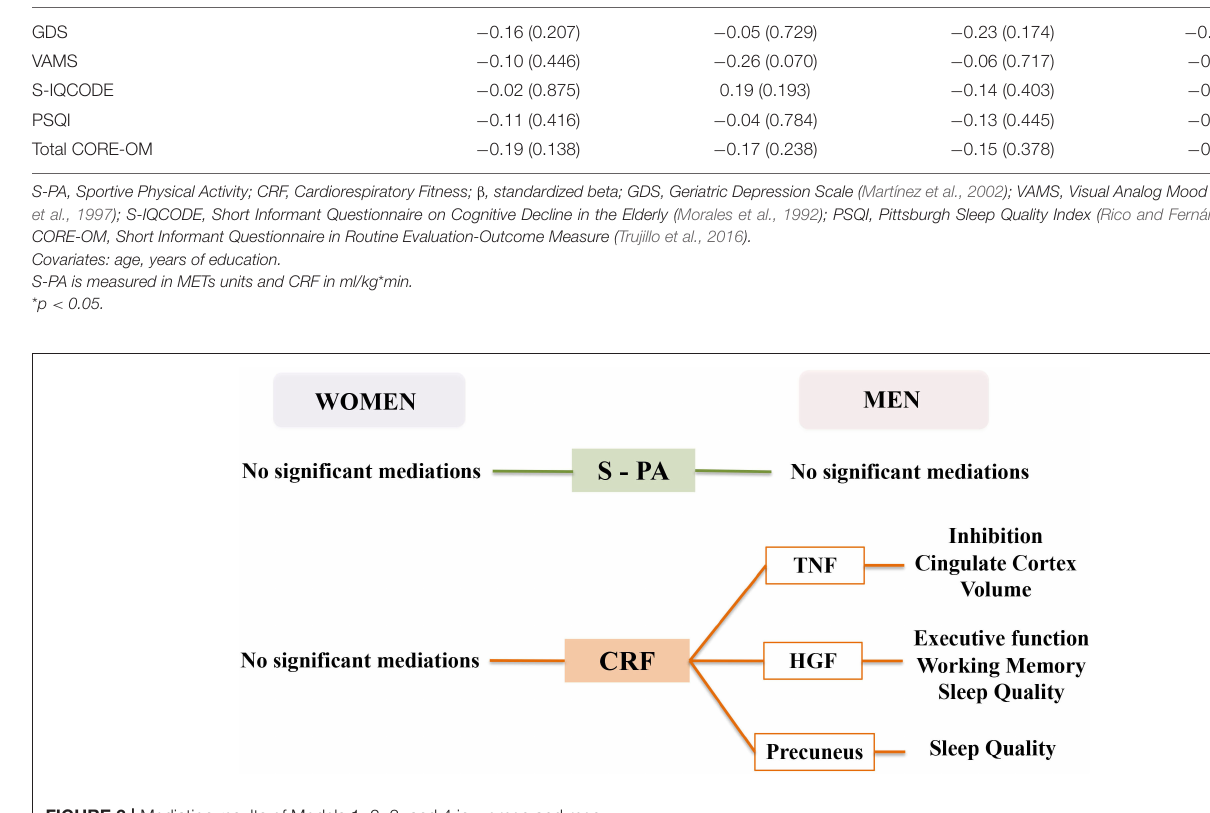
FIGURE 2 | Mediation results of Models 1, 2, 3, and 4 in women and